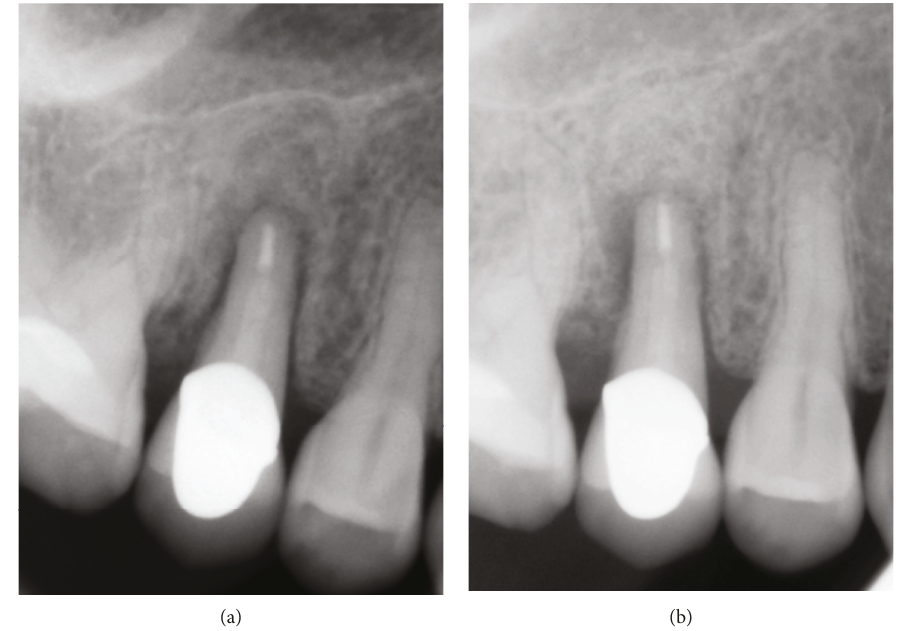
Figure 8: Three (a) and fi ve (b) months after endodontic surgery, the clinical scenario did not improve: a progressive radiolucency involved the distal areas of the tooth and proximal